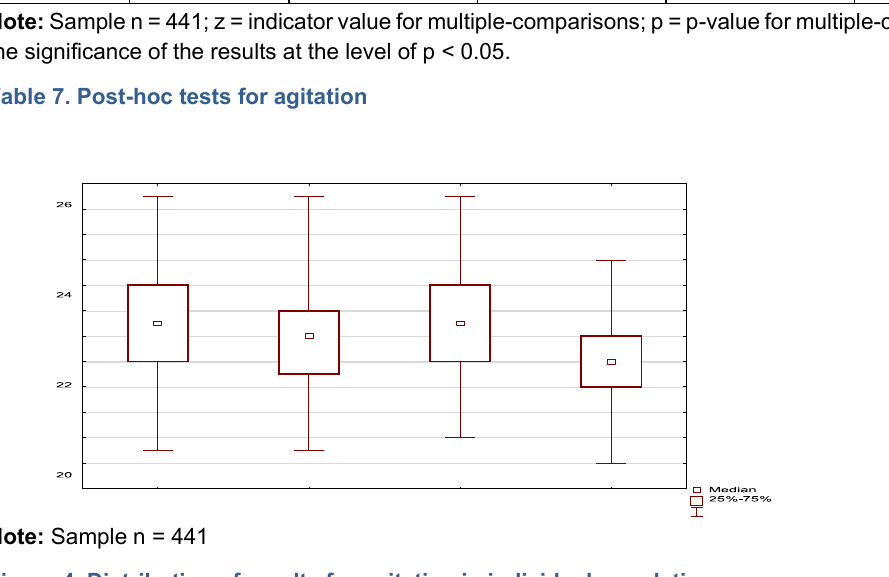
Violence Violence, one of the two manifestations of the most destructive passive behaviors (Schiff ,